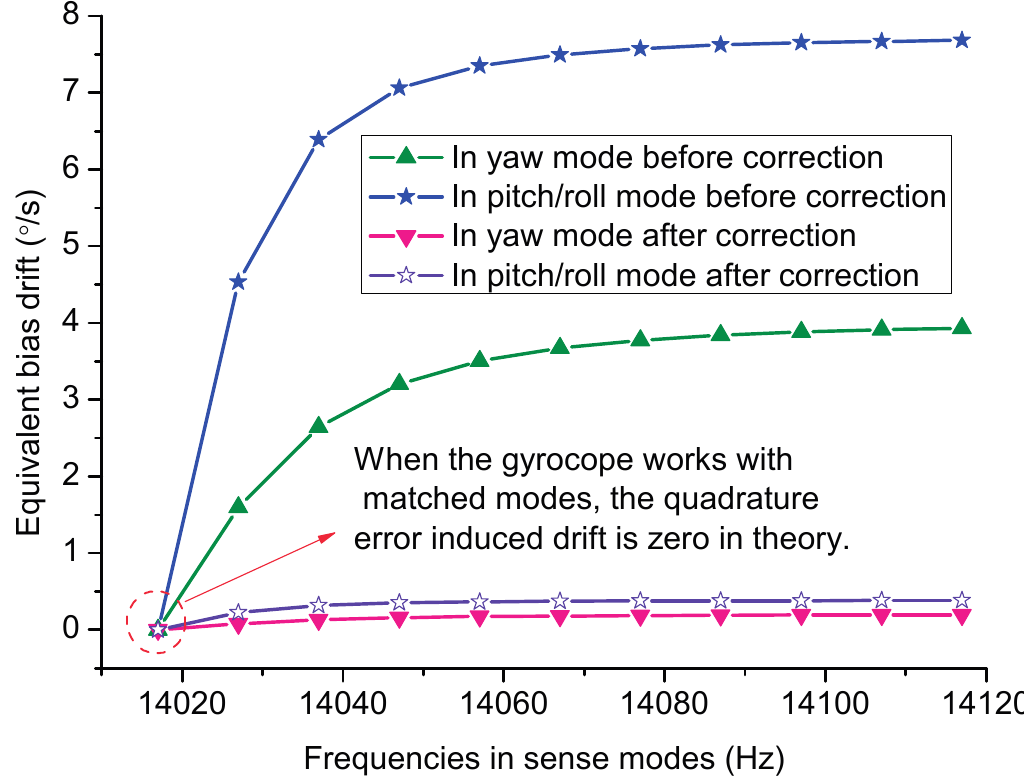
Figure 13. Equivalent bias drift versus sense mode frequencies before and after quadrature error